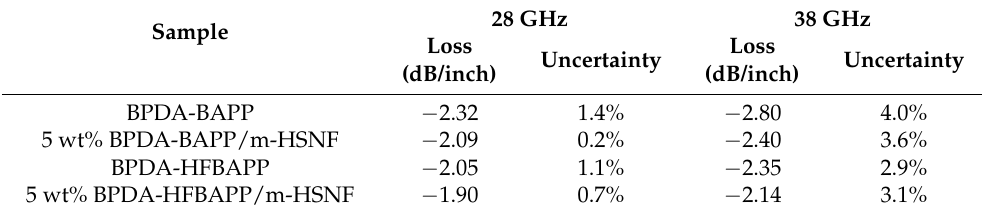
Figure 7. S 21 insertion loss versus frequency of ( a ) BPDA-BAPP and 5 wt% BPDA-BAPP/m-HSNF nanocomposites and ( b ) BPDA-HFBAPP and 5 wt% BPDA-HFBAPP/m-HSNF nanocomposites. Table 6. Transmission loss properties of PI composites at 28 and 38 GHz.